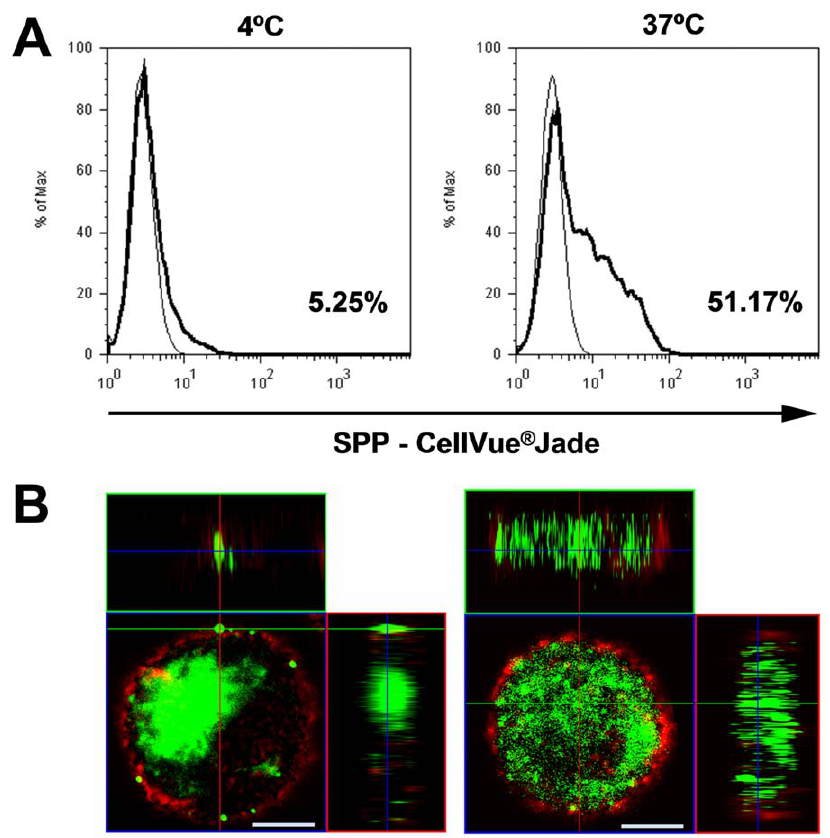
Figure 3. Uptake of SPPs by human moDCs. (A) Investigation of the percentage of human moDCs having attached/internalized SPPs by means of flow cytometry. Cells were incubated for 4 h with CellVue H Jade-labeled SPPs at 37 u C or 4 u C. The fluorescence of untreated cells (thin line) was used as a threshold level above which cells were considered to have attached SPPs (thick line). Numbers indicate the percentage of SPP attached/ internalized cells in a representative measurement from four independent experiments. (B) Visualization of SPPs in human moDCs by confocal laser scanning microscopy. Human moDCs were cultivated with CellVue H Jade-labeled SPPs (green) for 4 h, stained with PE-conjugated anti-hDC-SIGN (red), fixed, and visualized by confocal microscopy. Cells are shown at 40 6 magnification. Scale bar =5 m m.